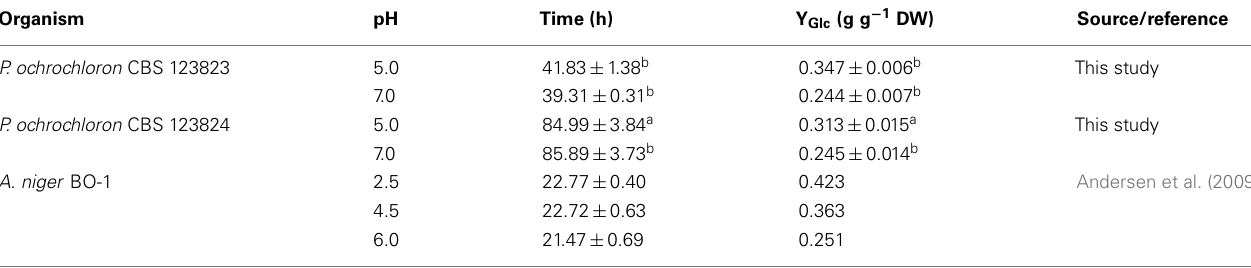
Table 1 |Yield on glucose at different ambient pH for Aspergillus niger and ammonium-limited batch cultures of Penicillium ochrochloron .